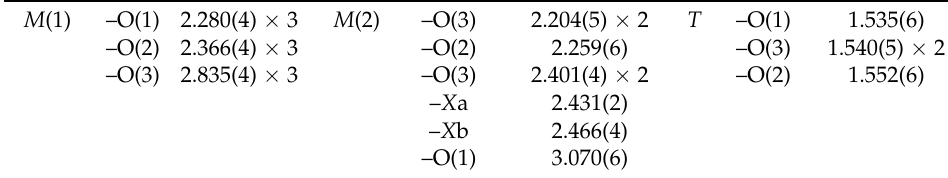
Table 4. Selected bond lengths (in Å) for